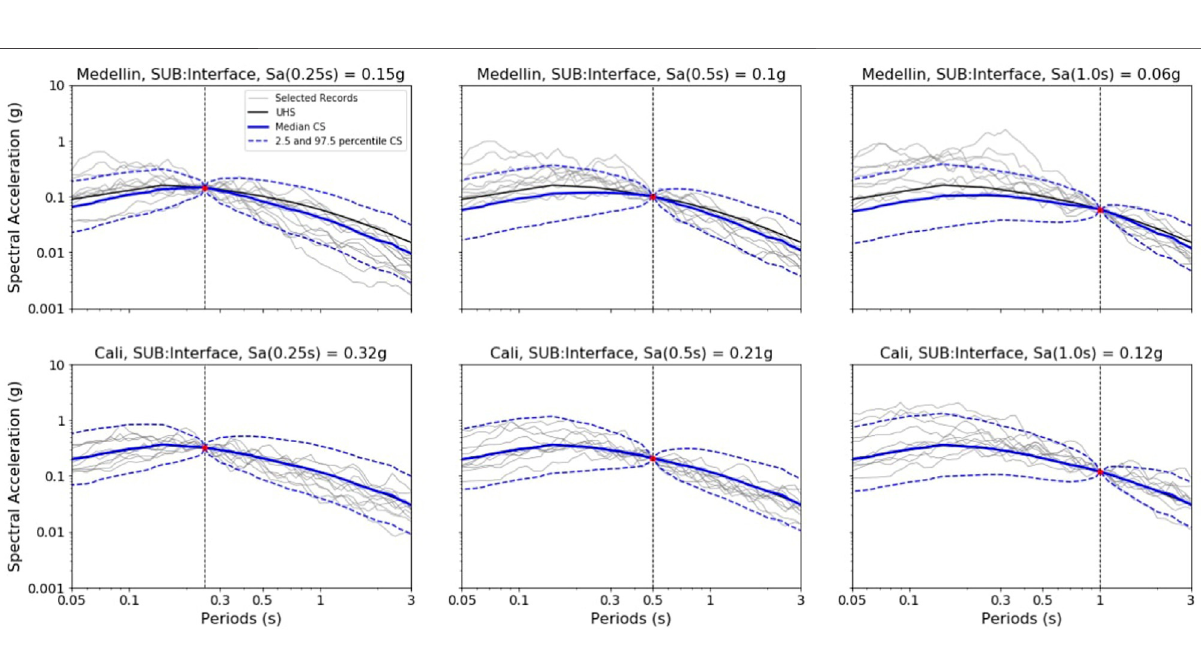
Frontiers in Earth Science |